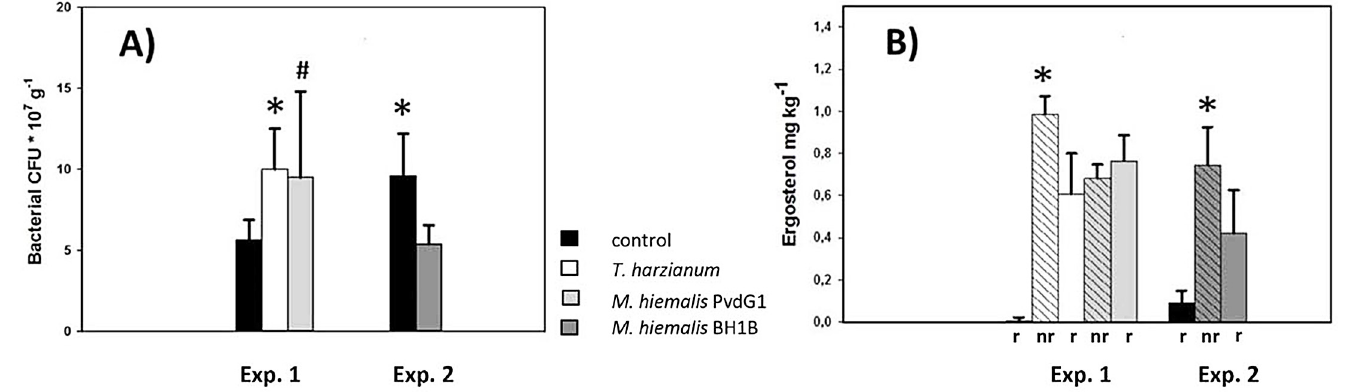
Fig 2. Bacterial numbers and fungal biomass (ergosterol) after 6 weeks of growth of Carex arenaria seedlings in quartz sand microcosms. 1A: Number of bacterial colony forming units in the Carex rhizosphere (root-adhering sand); * indicates significant difference (p < 0.05) between microcosms with and without (control) the presence of inoculated fungi, # indicates p = 0.052 for Log-transformed data. 1B: Ergosterol concentrations. r indicates rhizophere sand (sand adhering to Carex roots), nr indicates sand remaining after removal of Carex roots. * indicates significant difference (p < 0.05) within fungal treatments between root-adhering and non-root-adhering sand. Data for both figures are the averages of 5 or 6 sand microcosms. Error bars represent standard deviation.